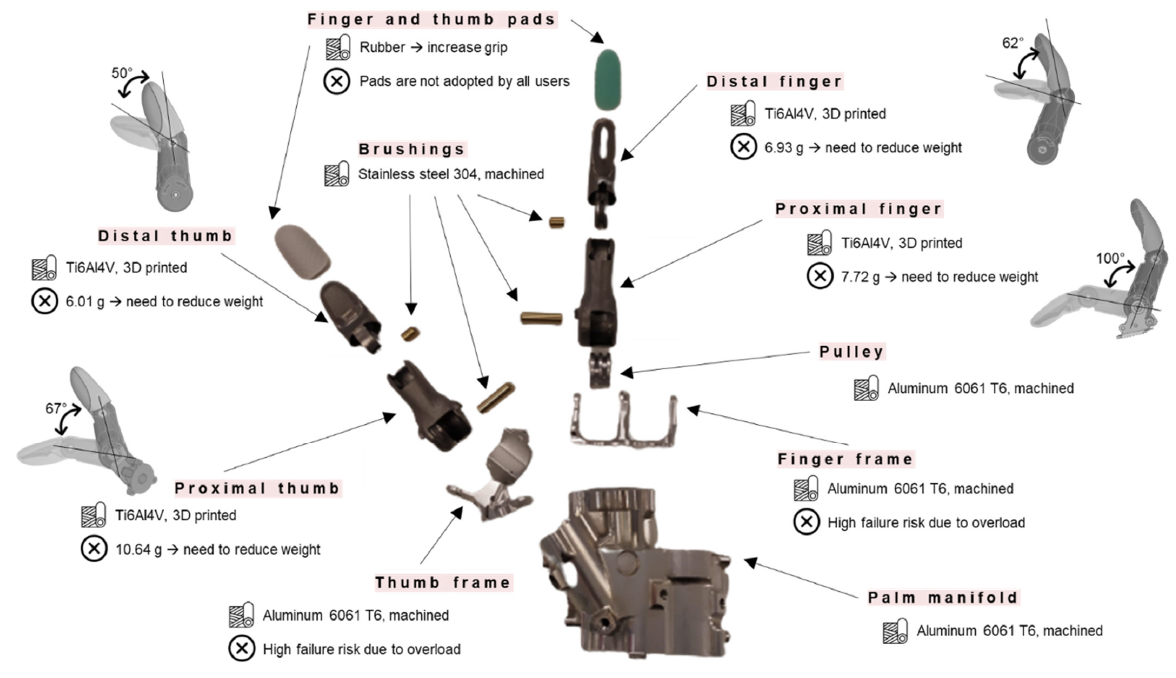
Figure 2. MyHand main components. Material and production process, together with rotations of proximal and distal components, and eventual criticalities experienced by users are highlighted.